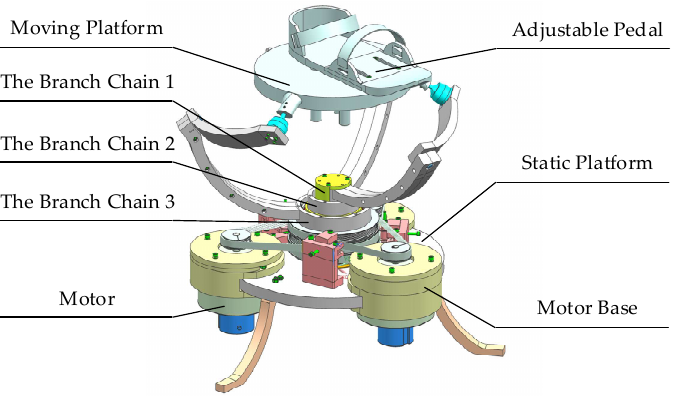
Figure 2. Branch-chain structure of RRS.